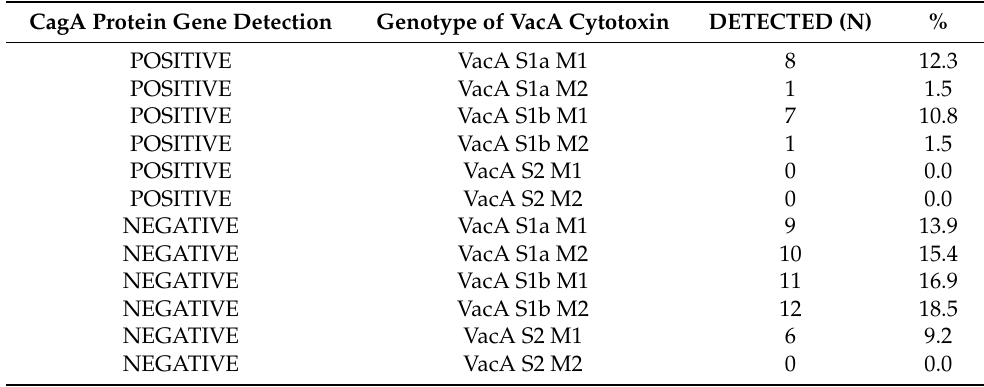
Table 6. Distribution of the different Helicobacter pylori genotypes in positive samples of the chronic tonsillitis groups: (a) inflammation, n = 65.